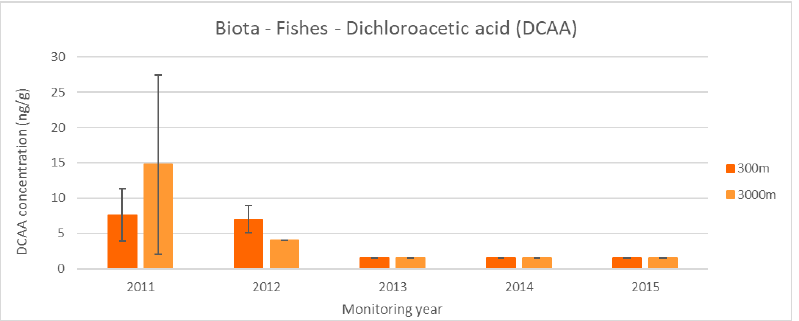
Figure 8. Chloroform concentrations (means ± L-levels) in fish samples collected from 2010 to 2015 at two sites located near the LNG terminal in the Northern Adriatic Sea.